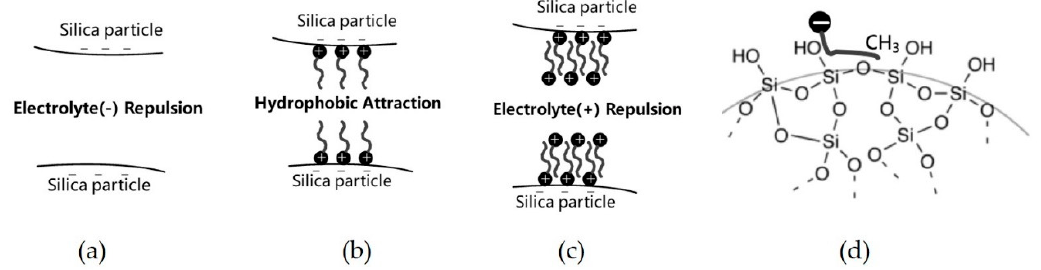
Figure 12. Microcosmic behaviors of two silica particles in the different adsorption regions for DPC adsorption and SDS adsorption mechanism. ( a ) the silica particles are repulsed by each other without any adsorption; ( b ) hydrophobic attraction generated in case of monolayer adsorption; ( c ) electrolyte repulsion generated in case of bilayer adsorption; ( d ) SDS adsorption mechanism.